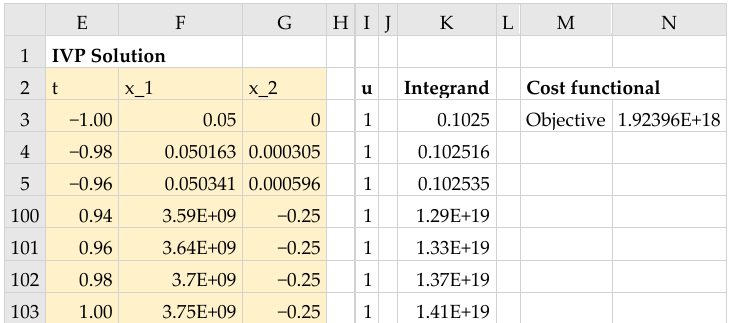
Figure 9. Partial listing of computed results by Formula (16). Also shown are generated control and integrand columns, and the initial objective formula value. The associated formulas are listed in Table 2. Math. Comput. Appl. 2018 , 23 , x FOR PEER REVIEW